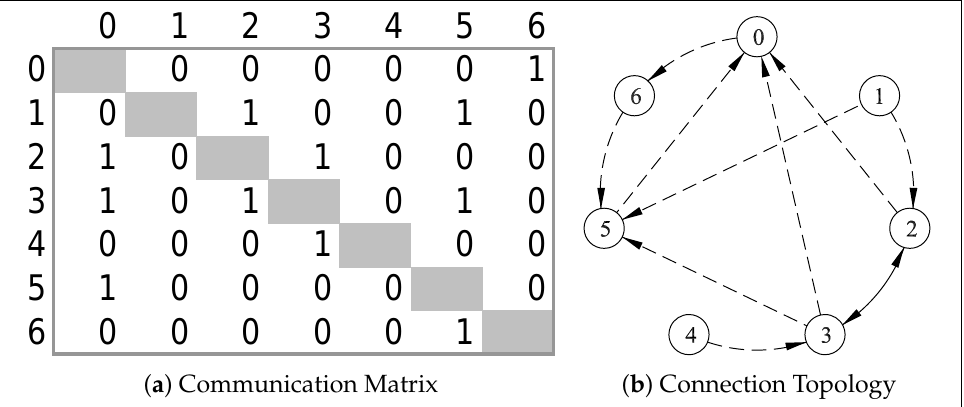
Figure 14. Randomly connected topologies for a given communication matrices (adopted from [47]). Note: The communication matrix and topology is generated every time before solution migration occurs.